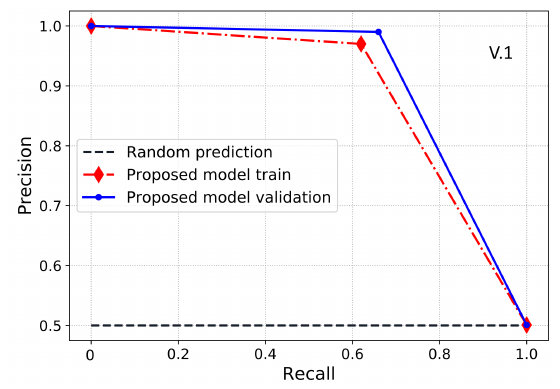
Figure 10. Proposed model’s PR-AUC-based analysis without using IQMOT.